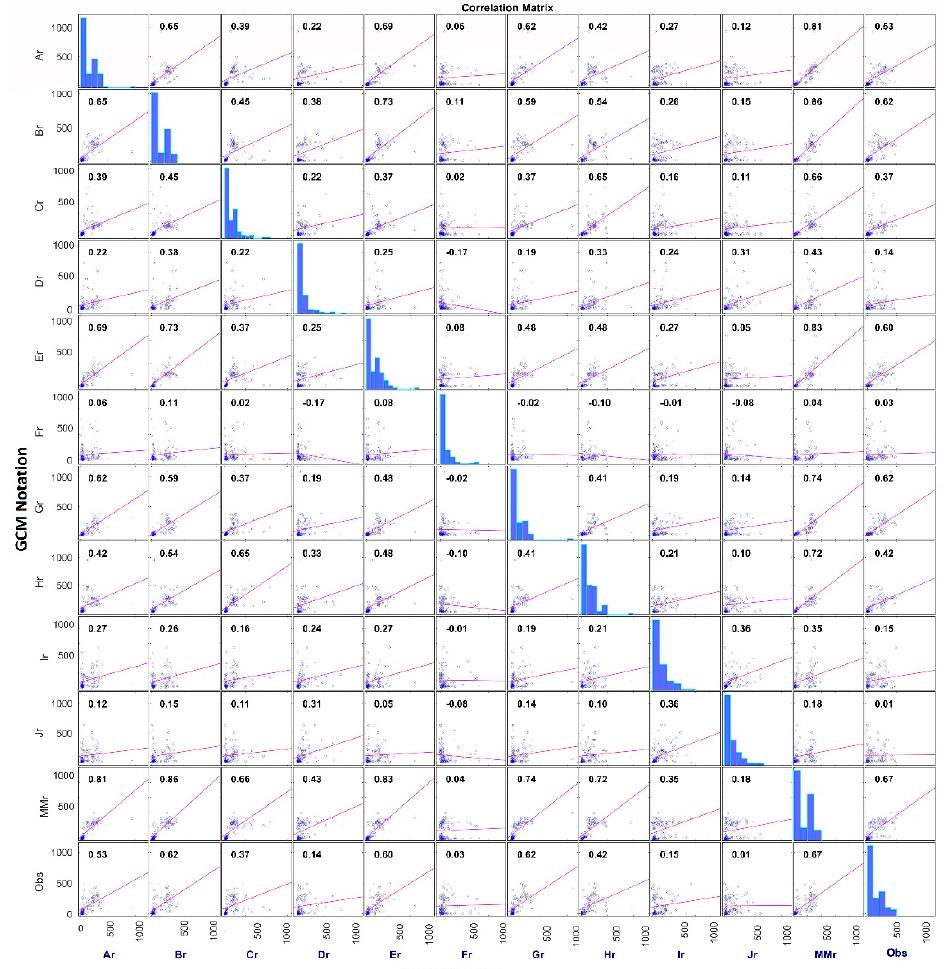
Figure 17. Correlation matrix of downscaled precipitation for different GCMs with the Re-Obs model for Zone 4. Notations are given in Table 5. Numbers in scatter plot show the correlation coefficient between two GCMs. Diagonal of matrix represents histogram of observed precipitation and downscaled precipitation for a particular GCM.